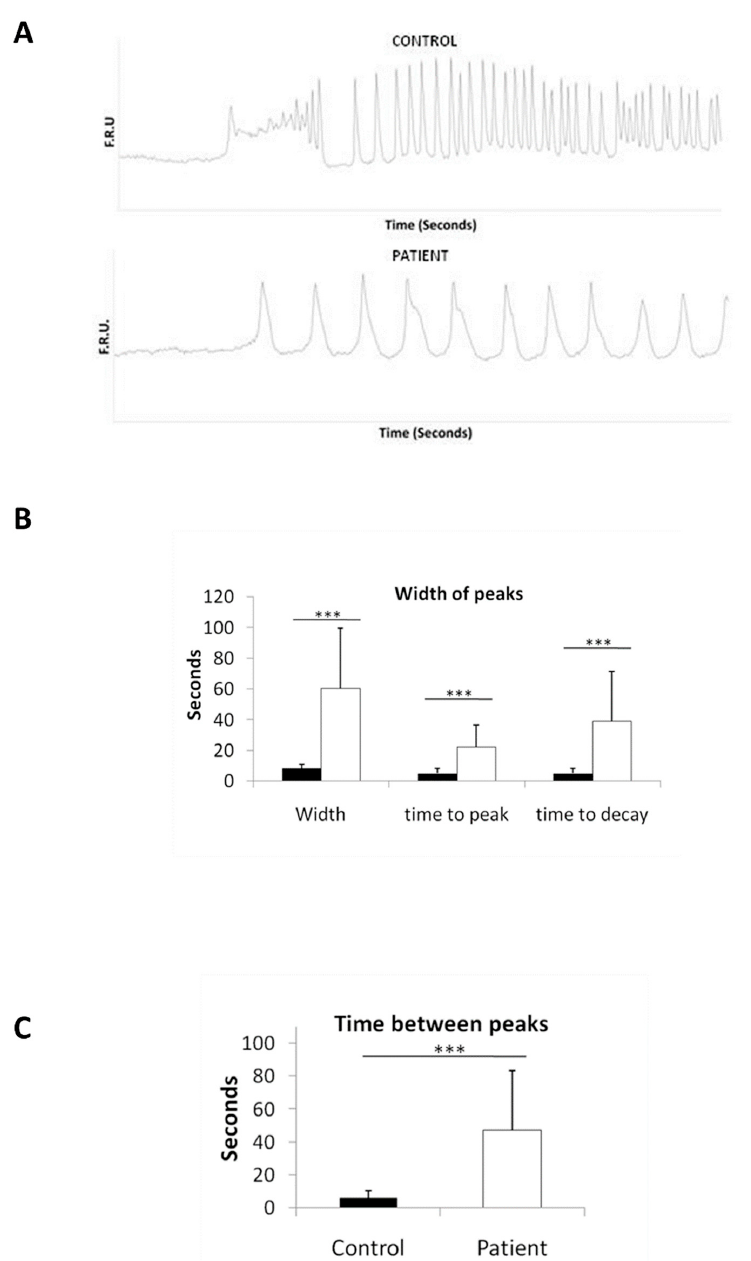
Figure 6. Calcium dysregulation in LS iPSC-derived neurons. ( A ) Representative plots of calcium imaging displaying a different response to KCl in LS iPSC-derived neurons. FRU: fluorescence relative units. ( B ) Quantification of the width of the peaks (from basal to basal), time to peak (from basal to peak) and time to decay (from peak to basal). ( C ) Quantification of the time between peaks. (*** p -value < 0.001)